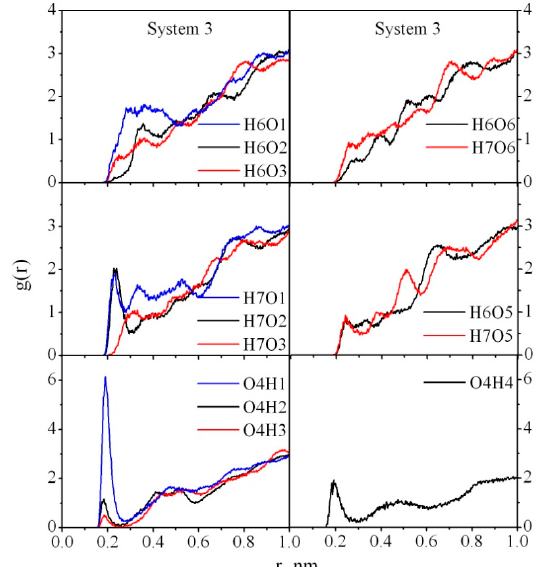
Figure 8. Atom–atom radial distribution functions for PAM–CNC in System 3.